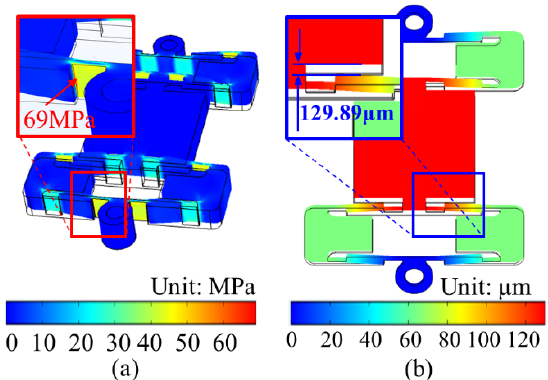
Figure 6. Static analysis of the series bridge mechanism: ( a ) stress analysis; ( b ) displacement analysis.